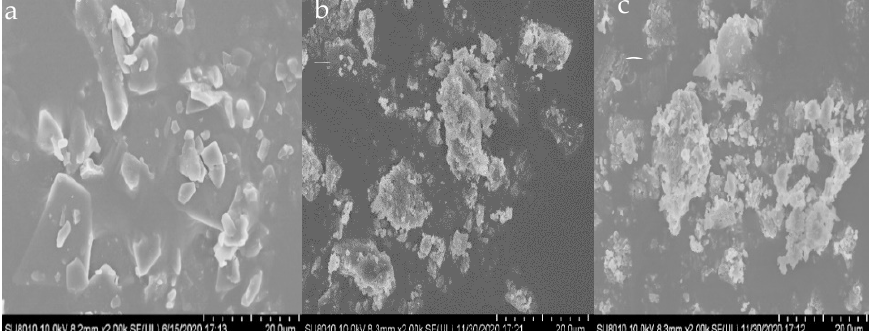
Figure 5. The SEM graphs of WSG and its conjugates: ( a ) WSG; ( b ) WSG-PPI conjugates; ( c ) WSG-SPI conjugates.